Question: What style of plot is this figure drawn as?
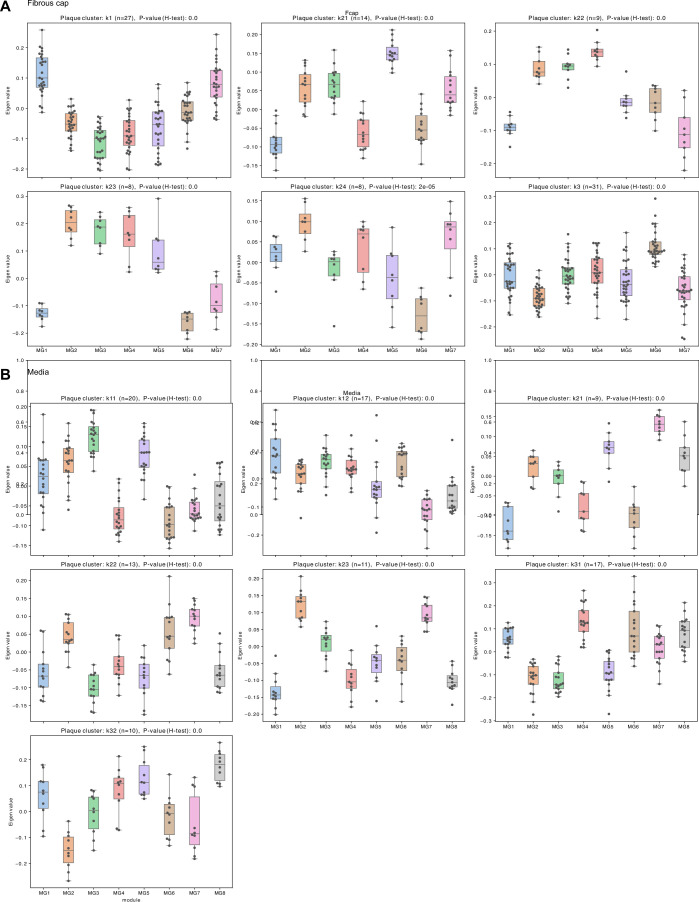
Answer: pie